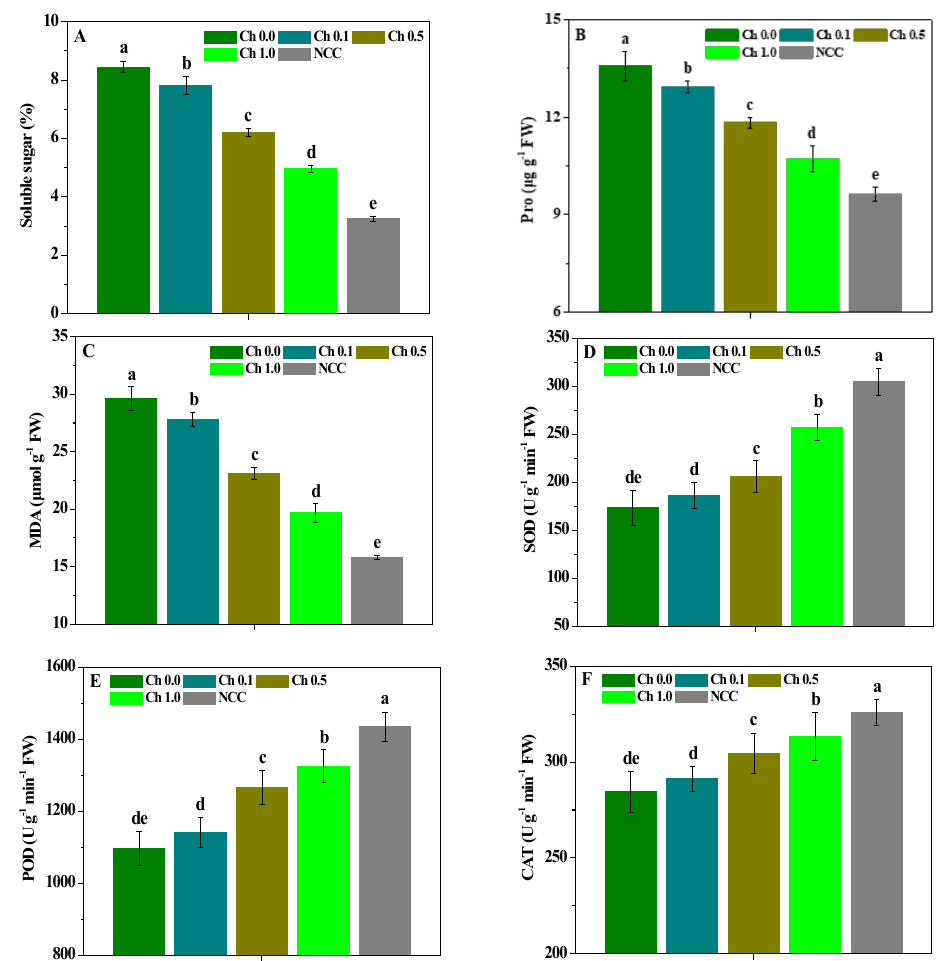
Figure 4. The influence of chitosan spraying on the soluble sugar ( A ), Pro ( B ), MDA ( C ), SOD activity ( D ), POD activity ( E ), and CAT activity ( F ) of P. ternata . Error bars show SD, and different letters indicate significant differences at 5% ( p < 0.05) level.